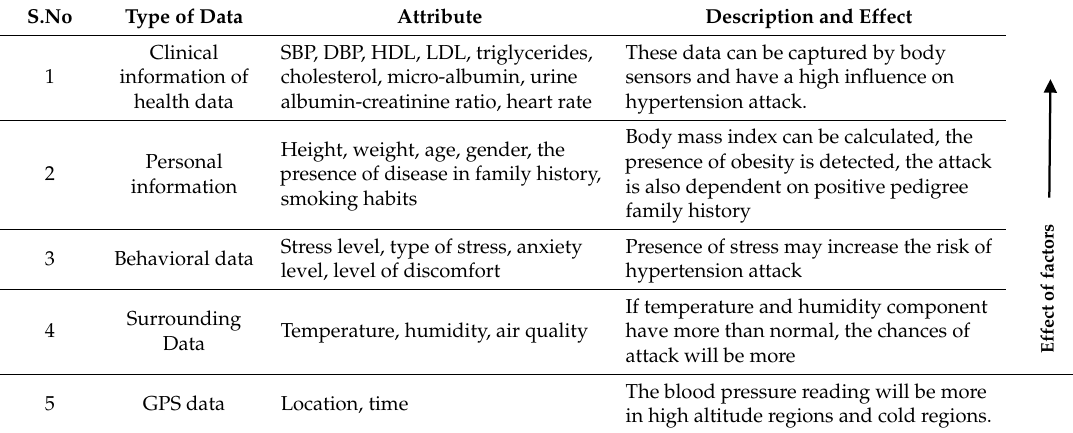
Table 1. Types of data used, their attributes, and their effect.